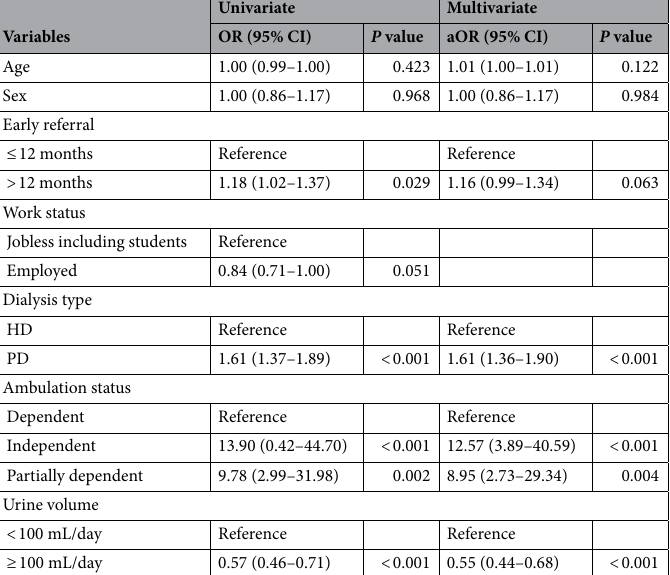
Table 4. Factors associated with planned dialysis by logistic regression model. OR odds ratio, CI confidence interval, aOR adjusted odds ratio, HD hemodialysis, PD peritoneal